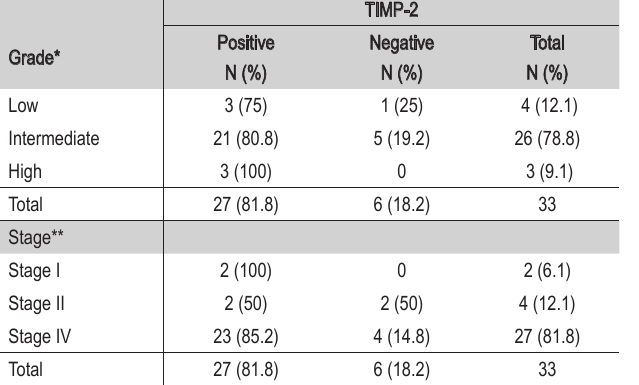
Table 4 - Association of TIMP-2 expression with grade and stage of OSCC (*p = 0.838 , **p = 0.169).